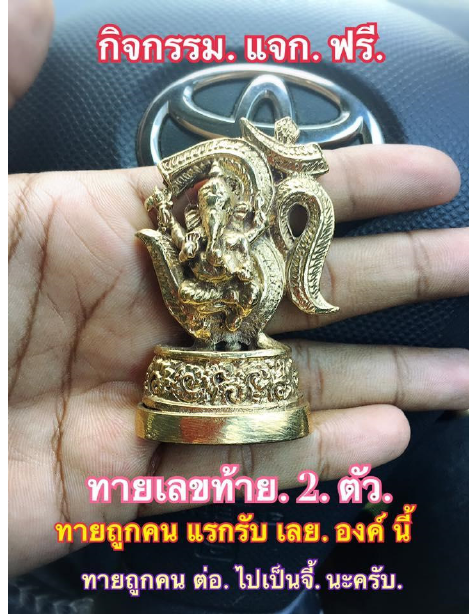
Figure 6. This is an example of a game ‘free give away to those you can predict the last two digits of winning lottery numbers’ post shared by Mr. N on his Facebook page. Photo credit: Mr. N. Images used with permission.